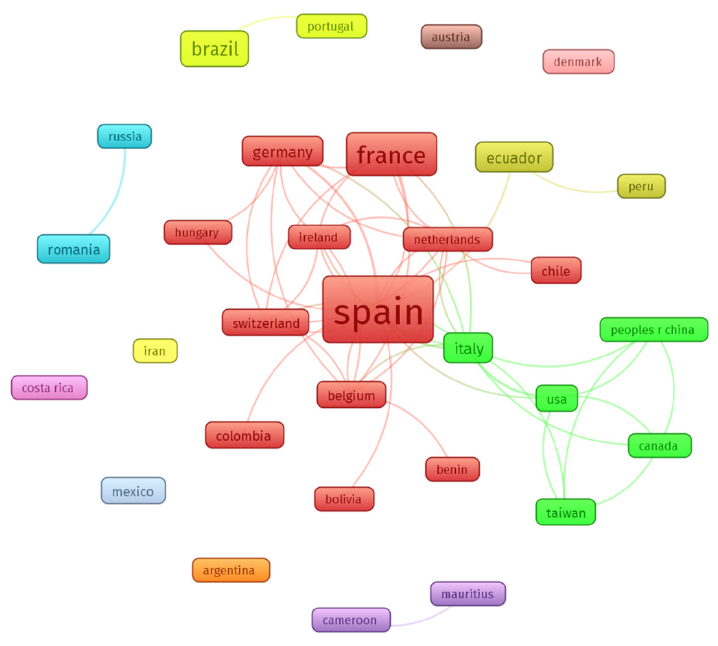
Figure 3. Co-authorship networks by countries/regions. Table 2. Bradford’s journals core, according to the number of articles in psychomotricity. Journals JCR Nº Art. % Art. % Acc. %